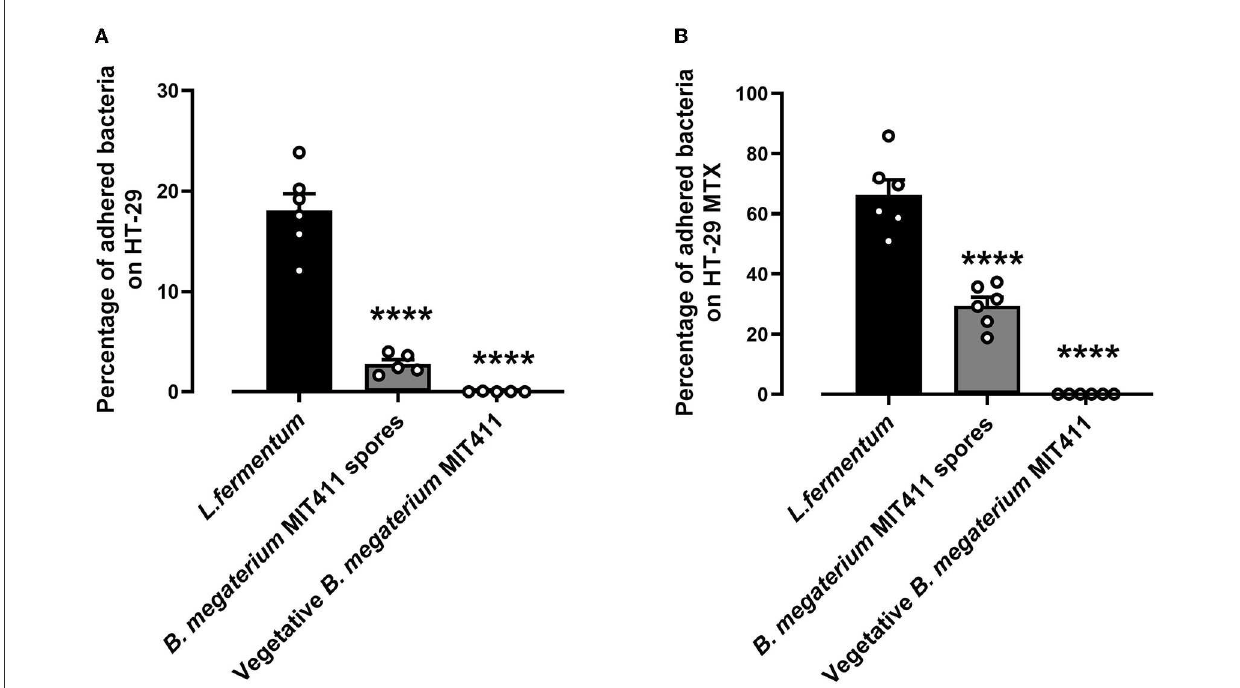
FIGURE2 Renuspore ® does not significantly adhere to (A) HT-29 and (B) HT-29 MTX cells at 37 ◦ C compared with L. fermentum . Significant difference observed between Renuspore ® and L. fermentum . **** p < 0.0001. The results were statistically analyzed using Student’s t -test analysis (biological replicates n = 6) using GraphPad Prism